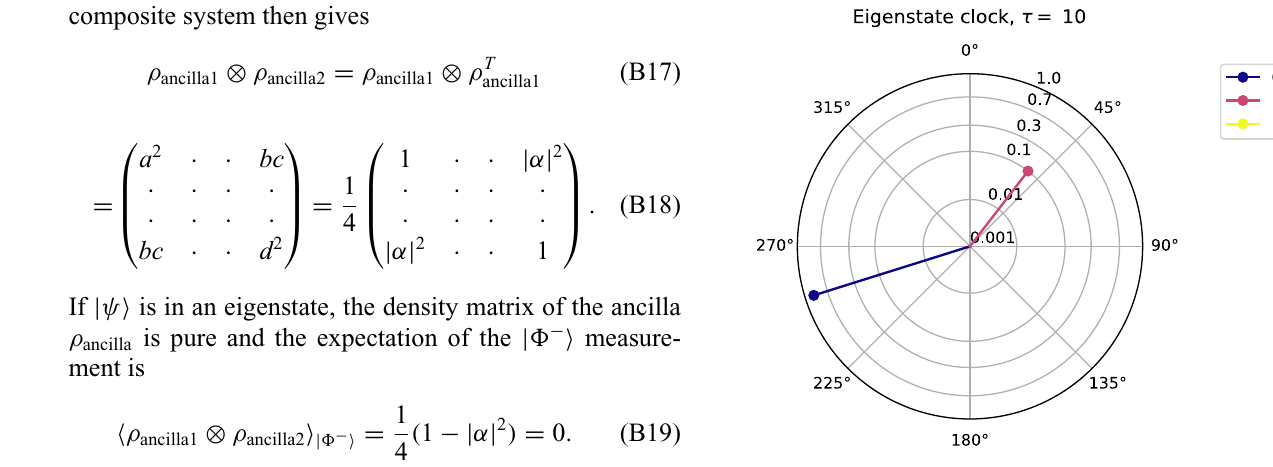
FIG. 18. The eigenstate clock for a second larger value of τ = 10. For τ =1, the summand corresponding to the ground state and the summand corresponding to the first excited state lie quite closely together in phase, which leads to problematic construc- tive interference (Fig. 4). However, as the pointers rotate with their respective eigenenergies for changing τ , they are well sep- arated for τ = 10. Then, we find destructive interference in the summation, which is necessary for the explanatory power of the protocol. Note that in this instance, the summands corresponding to higher excited eigenstates are very small and not